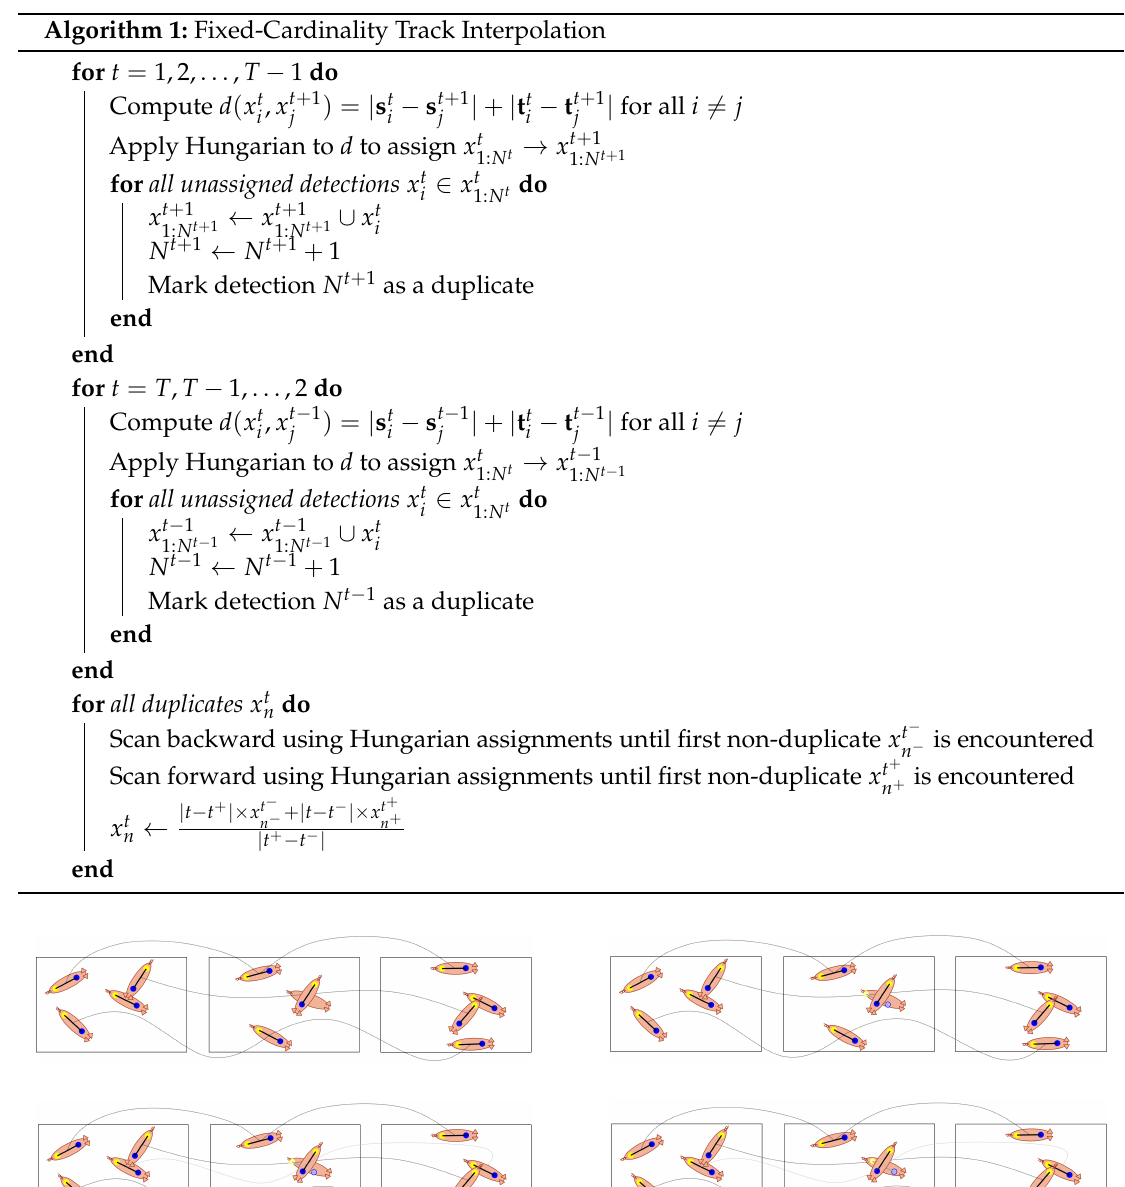
Algorithm 1: Fixed-Cardinality Track Interpolation